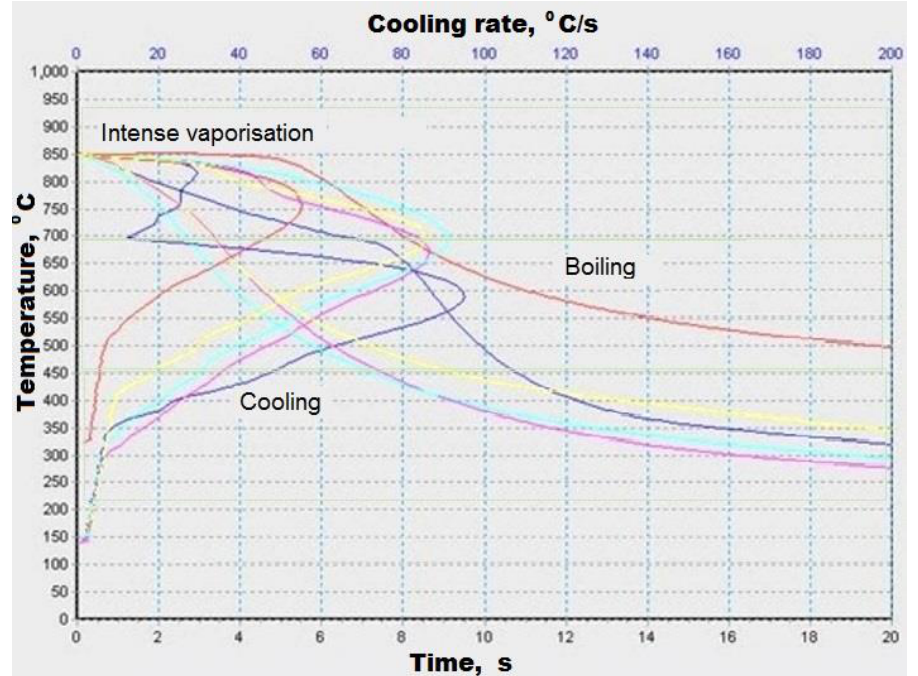
Figure 6. Quenching capacity of tested oils; Legend: mineral oil rapeseed oil bio oil at 300 °C bio-oil at 310 °C bio oil at 320 °C